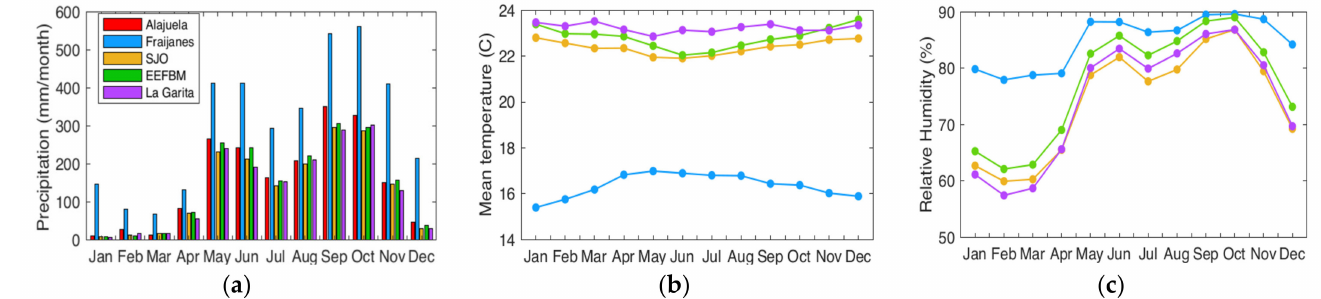
Figure 4. Data from the period from 1999 to 2020 showing ( a ) average accumulated precipitation, ( b ) mean temperature, and ( c ) relative humidity for the weather stations near La Hilda site in Alajuela. Alajuela, SJO, and La Garita are low elevation sites, while EEAFBM and Fraijanes are in the lower and upper limits of the elevation gradient at La Hilda. For the Alajuela site, only rainfall data were available for the selected period. Monthly accumulates and averages were estimated based on hourly data provided by the National Meteorological Institute.